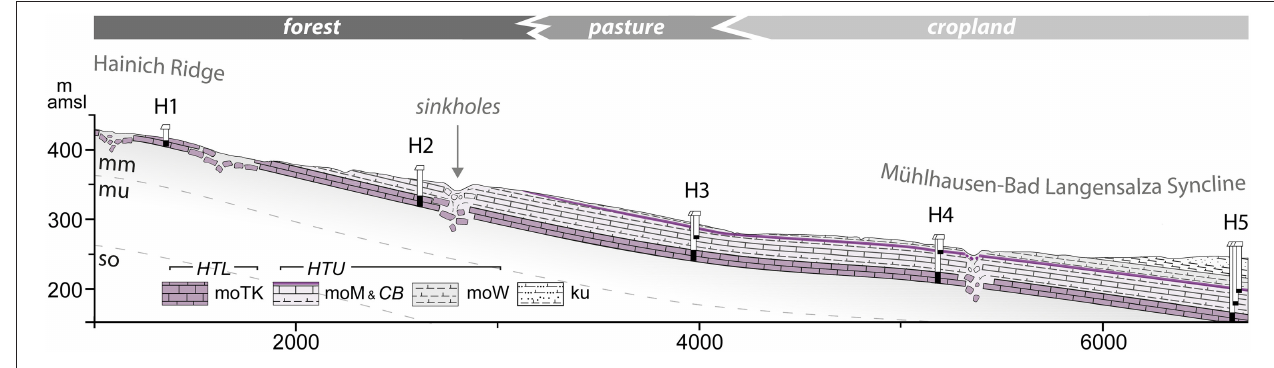
FIGURE 5 | Geologic cross section of the Hainich monitoring well transect from the eastern slope of the Hainich ridge (recharge area of target aquifers) to the syncline/discharge area. The black parts in the wells (H1 through H5) indicate main screen sections and accessed depths of the aquifer assemblages. Subrosion is depicted schematically. Vertical exaggeration is 4x. The transect spans different land use types, schematically illustrated. (Upper Buntsandstein, mu, Lower Muschelkalk; mm, Middle Muschelkalk; mo, Upper Muschelkalk; moTK, Trochitenkalk formation; moM, Meissner formation; CB, Cycloides-Bank; moW, Warburg formation; ku, Lower